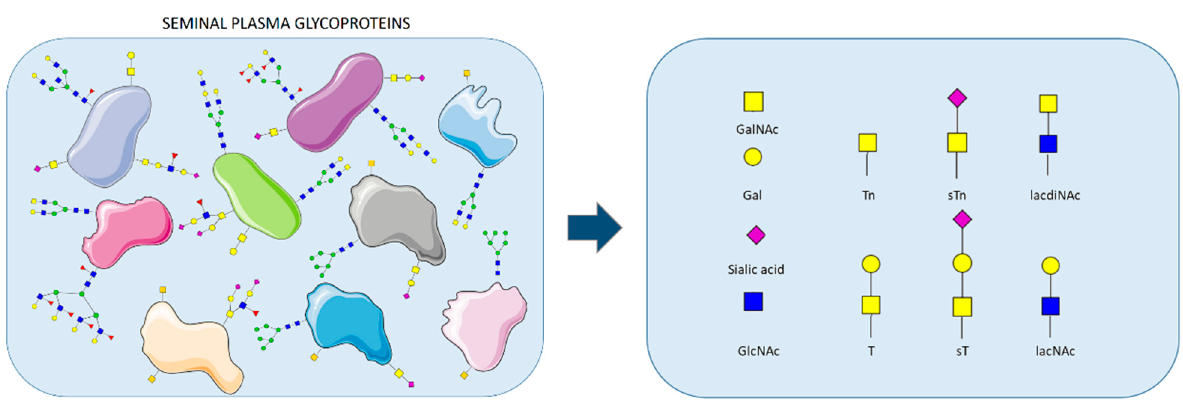
Figure 1. The schematic representation of seminal plasma glycan structures, highlighting the antigens analyzed in this study. Images were taken from Servier Medical Art (https://smart.servier.com (accessed on 14 June 2021)) and modified by the authors under the following terms: Creative Commons Attribution 3.0 Unported License.